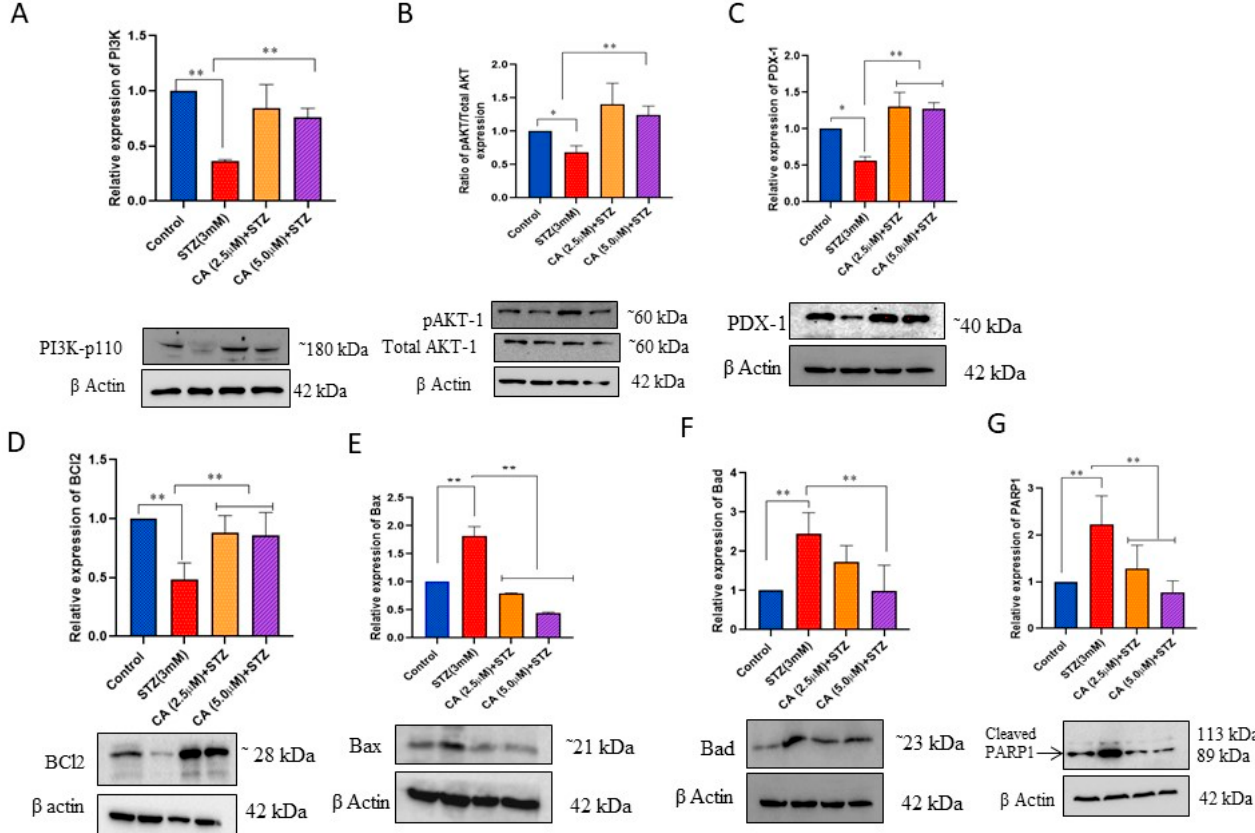
Figure 4. Effect of CA on protein expression. Western blot analysis of PI3K ( A ), AKT/p-AKT ( B ), PDX1 ( C ), BCL2 ( D ), BAX ( E ), BAD ( F ), and cleaved PARP1 ( G ) in STZ-treated cells for 3 h or cells preincubated with CA for 24 h followed by STZ treatment, compared to control cells. β -actin was used as an internal control. Data presented are obtained from three independent experiments. * p < 0.05 and ** p < 0.01. Bars represent mean ± SD.